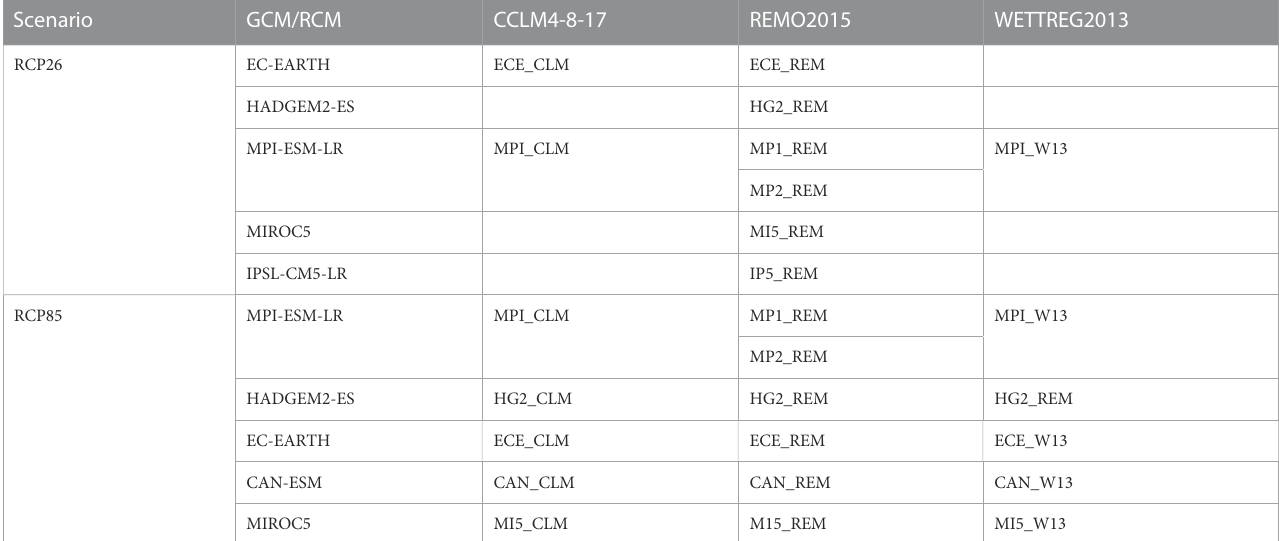
TABLE 1 List of climate models considered for analysis (Hübener et al., 2017).